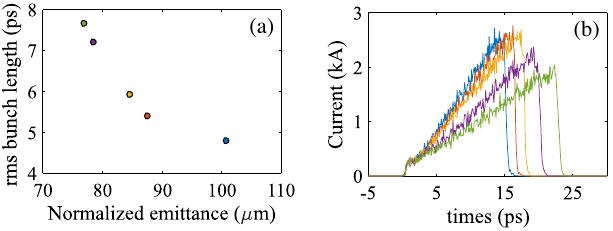
FIG. 8. (a) Simulated trade-off curve between transverse emittance and rms bunch length. (b) Corresponding current profiles.